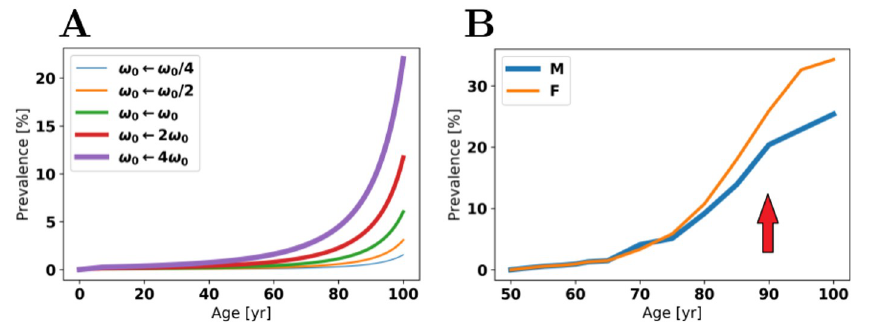
Fig 6. Significant variations of rate constants. A : the prevalence for the time-dependent model as ω 0 is scaled. B : clinically observed prevalence of AD in males (M) and females (F) [60] with inflection point marked by arrow.